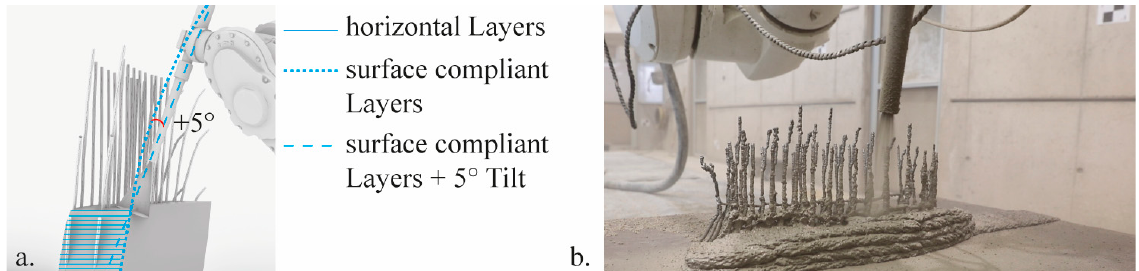
Figure 7. Different steps in path planning and printing process: ( a ) graphical representation of the printing relative inclination, ( b ) frame of the experimental printing phase.